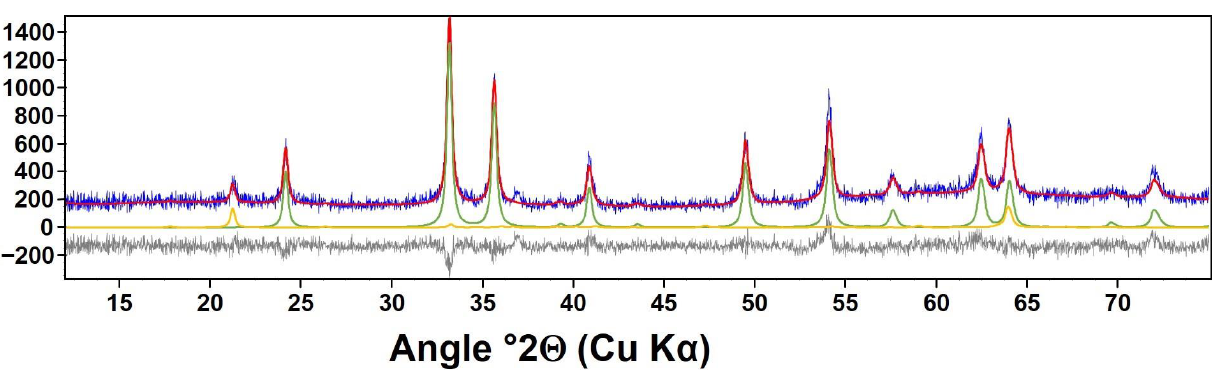
Figure 1. Experimental (blue line) and modeled (red line) powder X-ray diffractogram of the solid phase following the description in the experimental section. Also shown are the fit residual (grey line) and the contribution of hematite (green line) and goethite (orange line) to the diffractogram.